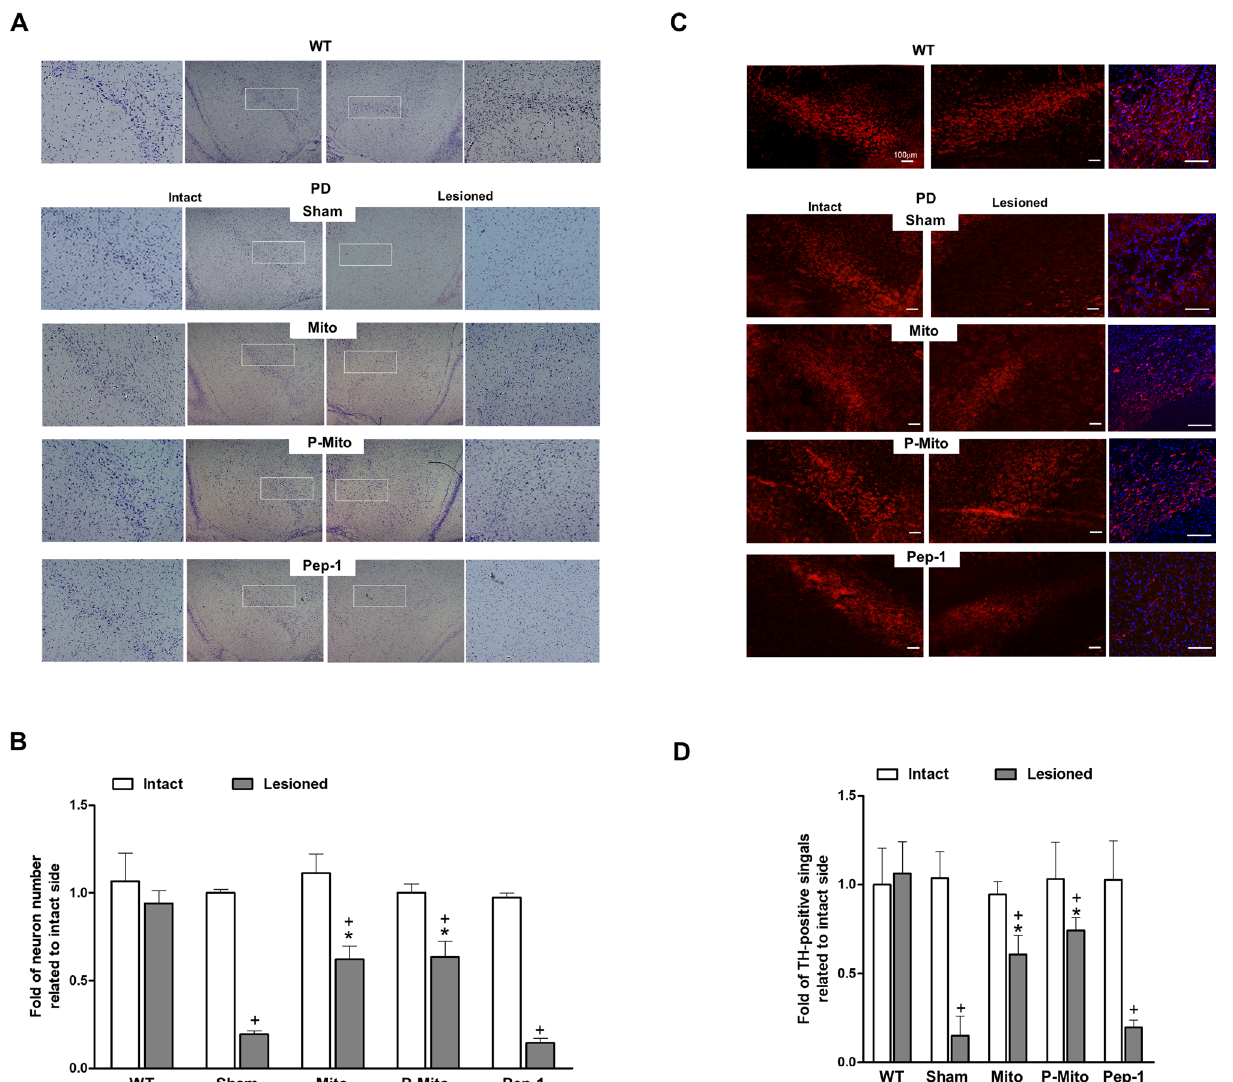
Figure 2. Mitochondrial infusions restore lost Nissl-stained neurons and dopaminergic (DA) neurons in the substantial nigra of Parkinson’s disease rats. ( A ) Nissl staining in coronal midbrain illustrates survival of neurons. The substantia nigra pars compacta (SNc) of the intact and 6-OHDA-lesioned sides, indicated by rectangles, was shown in high-magnification images in each left or right panel. ( B ) The number of Nissl- positive neurons was quantified by normalizing each contralateral control at the same magnification using ImageJ Software. ( C ) Slices were stained with tyrosine hydroxylase (TH) (red fluorescence) and 4 ′ ,6-diamidino- 2-phenylindole (DAPI) (blue fluorescence) to identify dopaminergic neurons and nuclei in the SNc. High- magnification images of TH fluorescence with DAPI nuclear counterstaining in right halves of WT and PD brain are shown in third column. ( D ) Quantification of TH-positive signals was performed similarly to normalize each contralateral control at the same magnification. + P < 0.05, vs. Intact; * P < 0.05, vs. Sham;